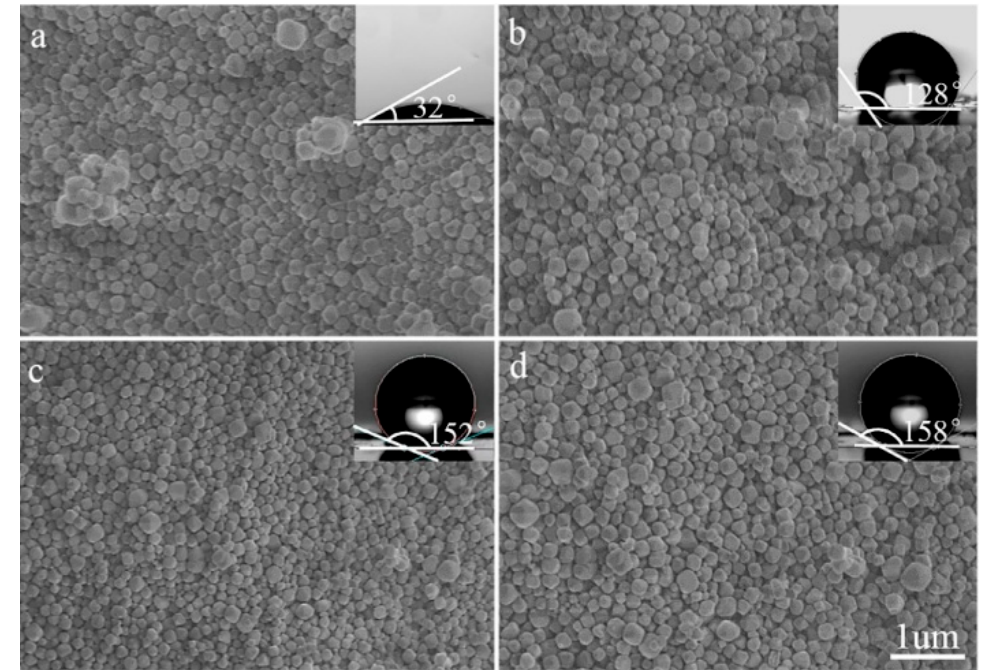
Figure 2. SEM images of ( a ) untreated MOF and ( b – d ) amine-functionalized MOF prepared with various concentrations of precursor. Inserts are photographs of water droplets used to determine the hydrophilic character. Reprinted from [77] with permission from Elsevier.